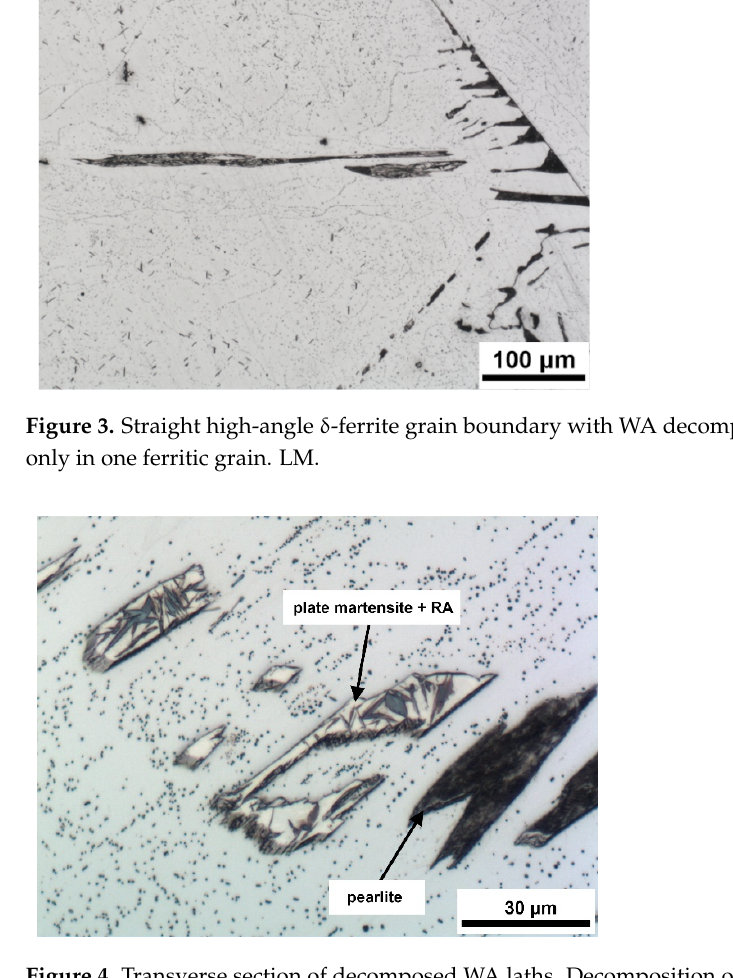
Figure 3. Straight high-angle δ-ferrite grain boundary with WA decomposition products occurring only in one ferritic grain. LM .